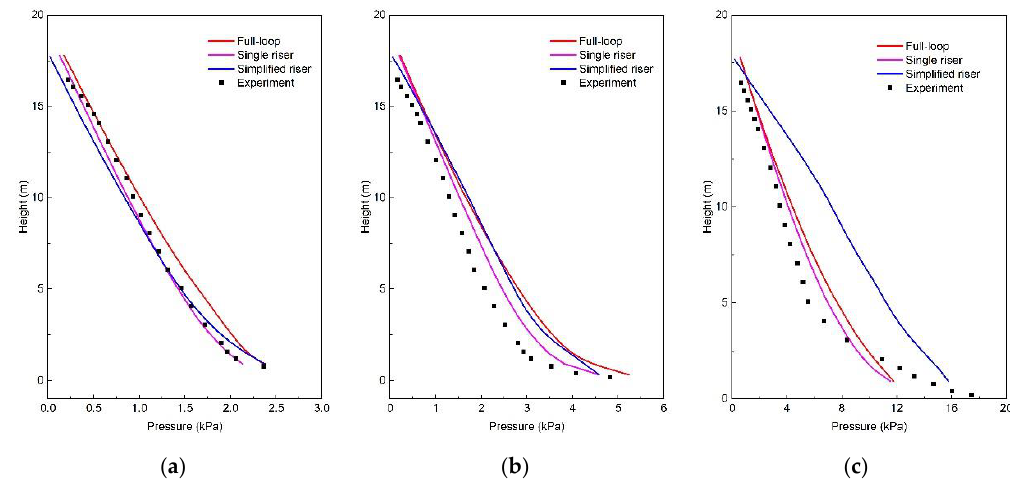
Figure 5. Comparison of time-averaged axial pressure profiles of the riser in different simulations at a constant superficial gas velocity of U g = 7 m s − 1 . ( a ) Gs = 50 kg m − 2 s − 1 , ( b ) Gs = 100 kg m − 2 s − 1 , ( c ) Gs = 300 kg m − 2 s − 1 .